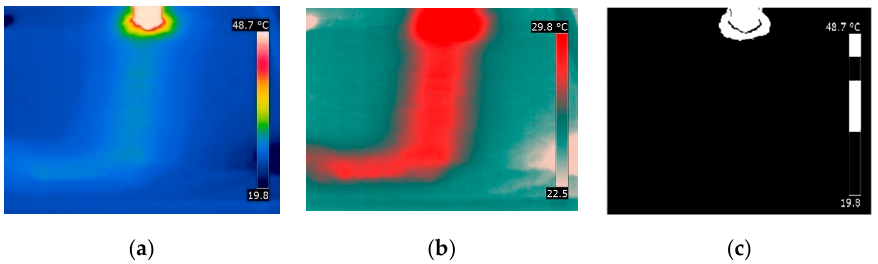
Figure A2. Image result as QIR in ( a ) processed with FLIR software (Greyred scale) in ( b ), and the result of the Otsu’s method in ( c ). Test ID: